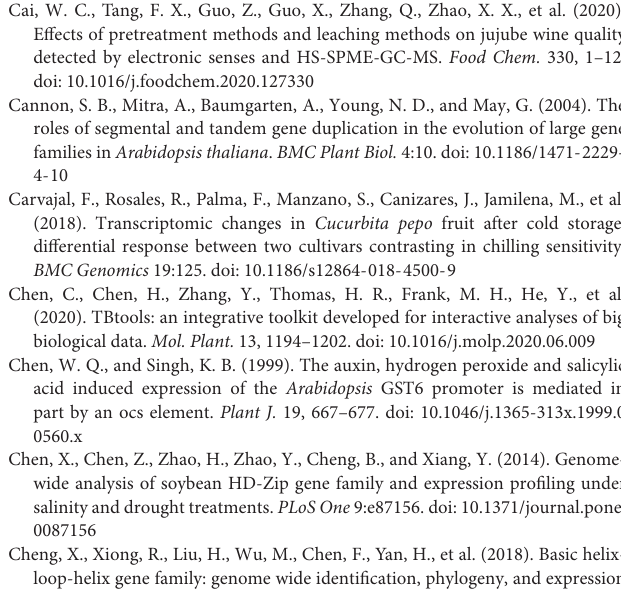
Supplementary Figure 1 | Putative motifs predicted in Hami melon GSTs. Supplementary Figure 2 | Ramachandran plot analyses of 3-D model of eight CmGST